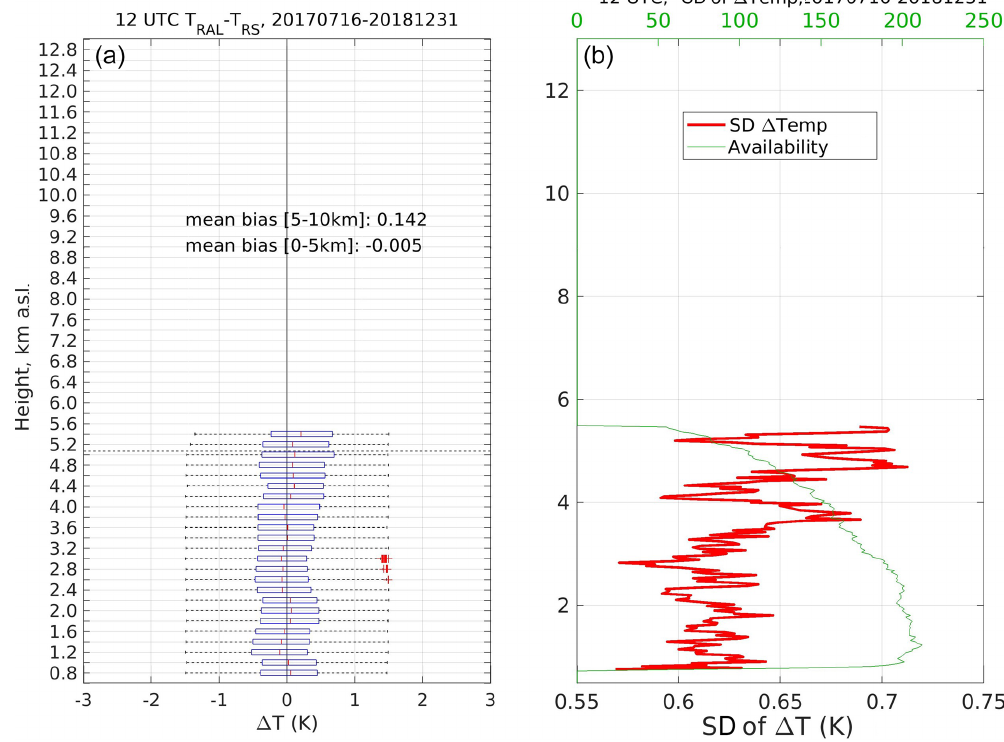
Figure 11. Daytime bias and standard deviation (SD) of (cid:49)T over the period July 2017–December 2018. In (a) , on each box of 200m vertical span, the central mark indicates the median, and the left and right edges of the box indicate the 25th and 75th percentiles, respectively. The whiskers extend to the most extreme data points not considered outliers, and the outliers are plotted individually and shown by the “+” symbol. Panel (b) shows the vertical profile of standard deviation (thick red) calculated over the altitude-decreasing number of (cid:49)T points (thin green).